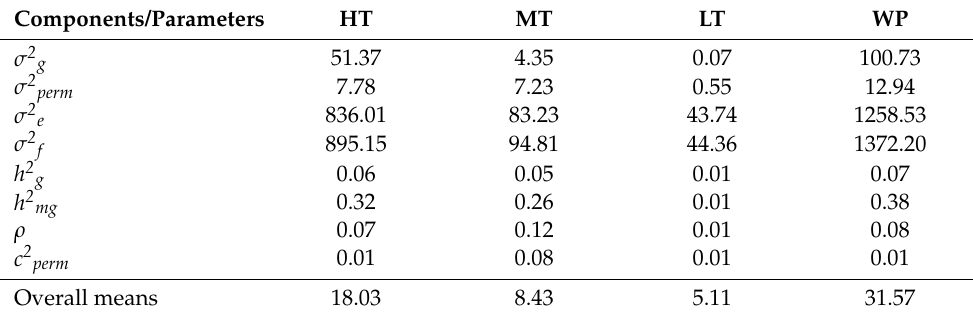
Table 2. Variance components and genetic and non-genetic parameters for Polyphagotarsonemus latus quantification in 36 common bean genotypes in three plant thirds: higher (HT), medium (MT) and lower (LT) and sum of the whole plant (WP).